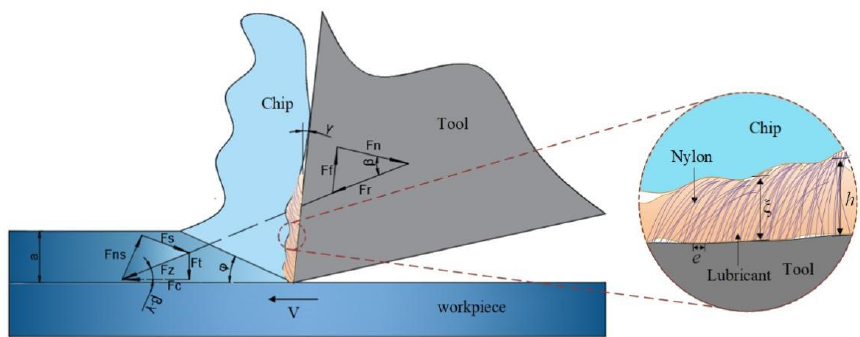
Figure 4. Two-dimensional equilibrium force system of the flocked broaches.